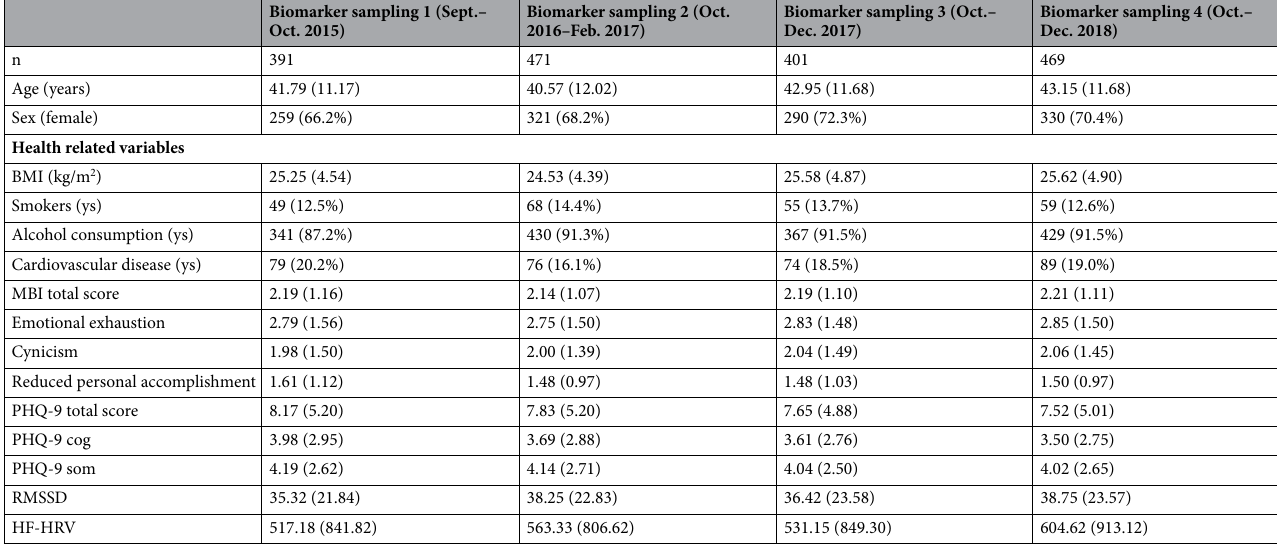
Table 1. Sample characteristics for those individuals included in the present analyses (Unless otherwise stated, number in brackets are standard deviations). BMI body mass index, Cardiovascular Disease self-reported hypertension and/or cardiac arrhythmias, HF-HRV high frequency heart rate variability, MBI Maslach Burnout Inventory, PHQ-9 Patient Health Questionnaire sum-score, PHQ-9 cog Patient Health Questionnaire 9— cognitive factor, PHQ-9 som Patient Health Questionnaire 9—somatic factor, RMSSD root mean square of successive difference between heart beats, ys number of participants who answered the respective